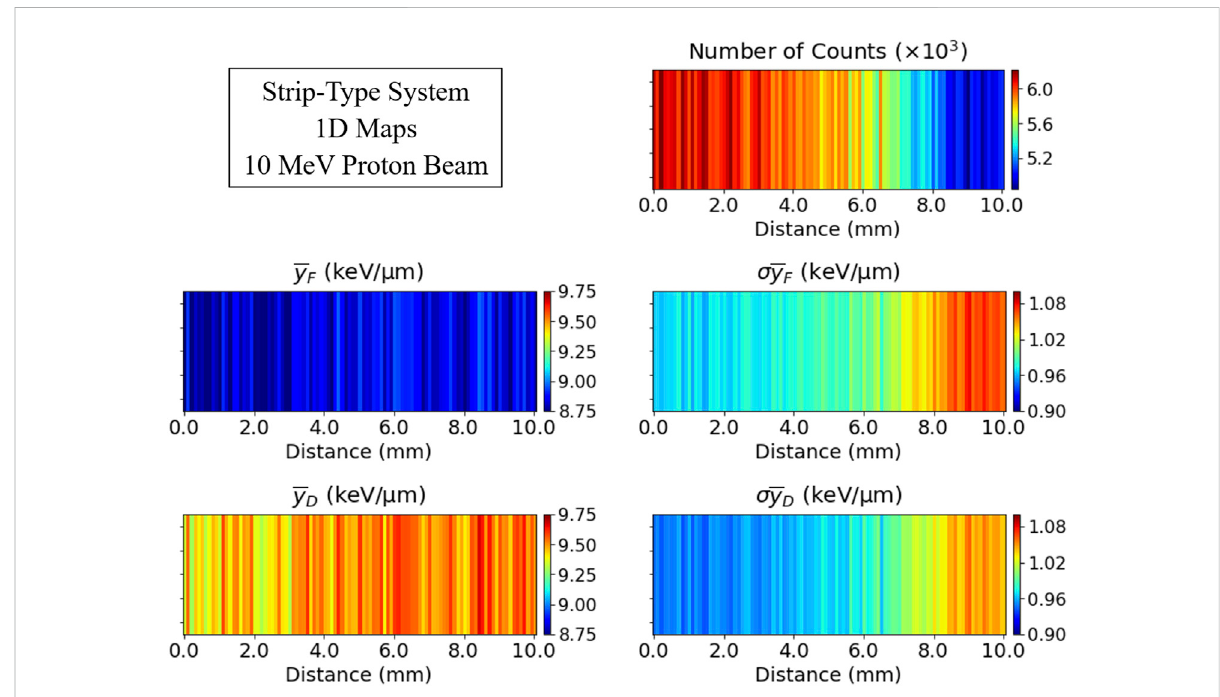
FIGURE 9 1Dmicrodosimetrymapsobtained withthestripsystemfor10 MeVprotons. Top:numberofparticlesdetected.Middle:frequency-meanlineal energy and its standard deviation. Bottom: dose-mean lineal energy and its standard deviation.